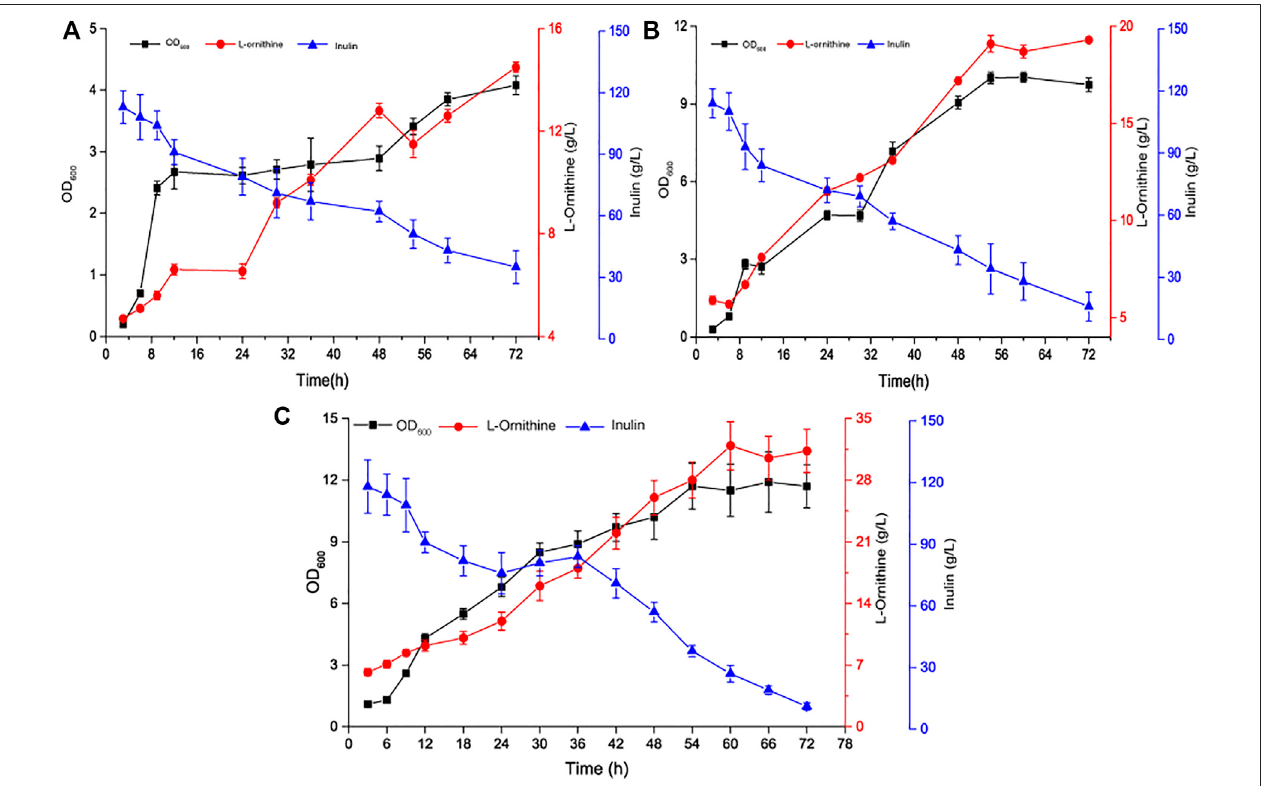
FIGURE 5 | The time curve of L-ornithine fermentation in a 7.5 L fermenter. (A) Time pro fi le of single-batch L-ornithine fermentation using inulin as the carbon source in a 7.5 L fermenter. (B) Time pro fi le of single-batch L-ornithine fermentation using inulin and sodium glutamate as the carbon source in a 7.5 L fermenter. (C) Time pro fi le of fed-batch L-ornithine fermentation in a 7.5 L fermenter. Fermentation conditions are as follows: the working volume is 3.5-L, the stirring rate is 400 rpm, the volume air per volume is 1 vvm, and the inoculation size is 6%.